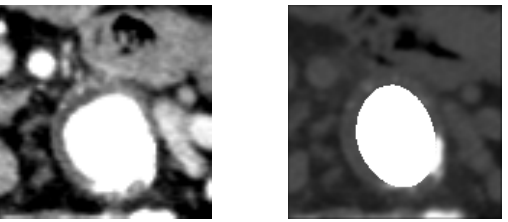
Figure 5. On the left, the reference image; on the right, the image extracted by the algorithm. For the above slice E m =